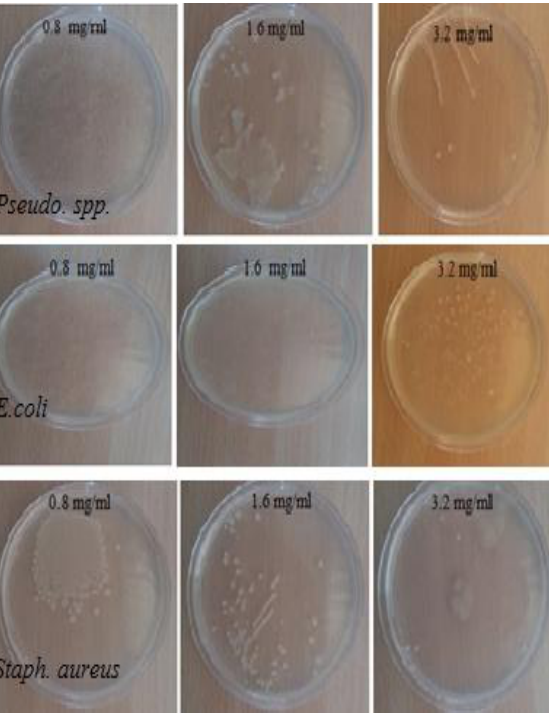
Figure, 6: Antibacterial activity of Zinc oxide Nano particles on Gram (-ve and +ve) bacteria in different